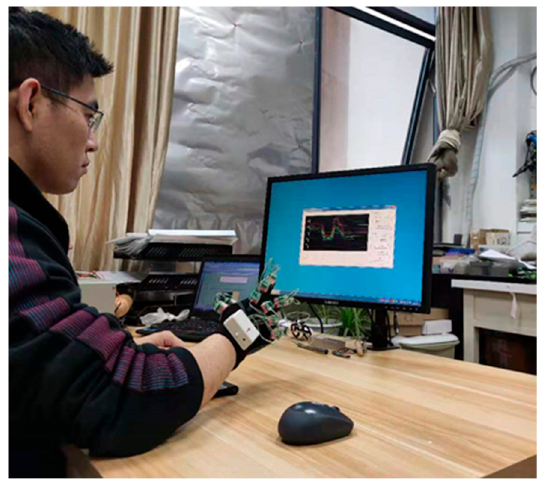
Figure 21. Experimental scene of digital gesture recognition. Table 7. Confusion matrix of Test A in gesture recognition experiment.